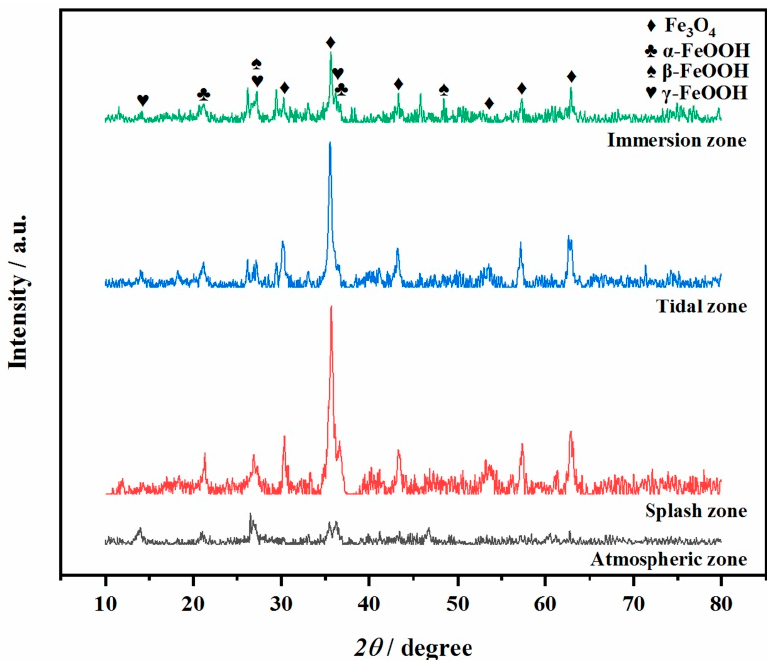
Figure 14. XRD spectra of the corrosion products formed on the surface of sensors exposed to different marine corrosion zones.